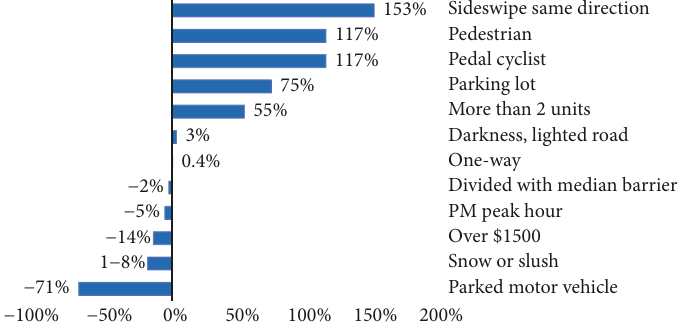
Figure 1: Percentage deviation of OR for statistically significant variables in HR and NHR Model (injury vs. PDO crashes).